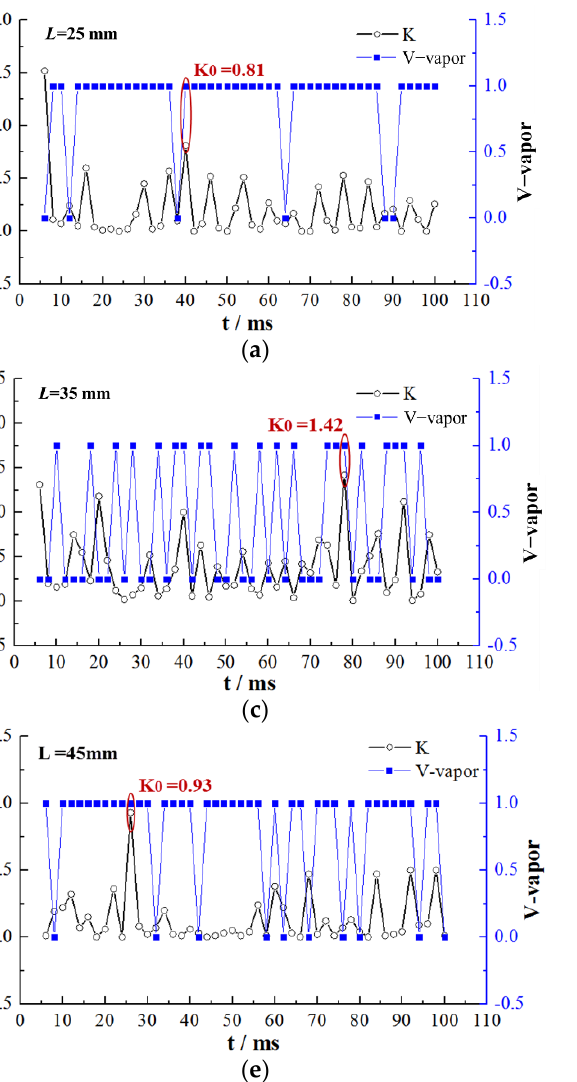
Figure 18. Cavitation numbers with nozzles of various cavity lengths ( a ) L = 25 mm ( b ) L = 30 mm ( c ) L = 35 mm ( d ) L = 40 mm ( e ) L = 45 mm and ( f ) L = 50 mm.